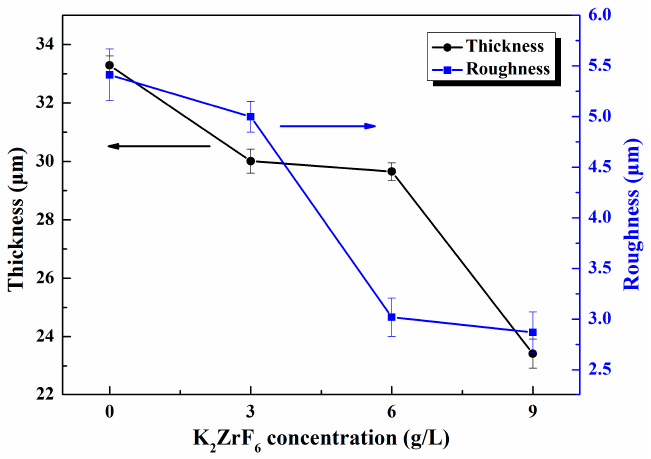
Figure 1. Thickness and roughness of the micro-arc oxidation (MAO) coatings under different K 2 ZrF 6 concentrations.